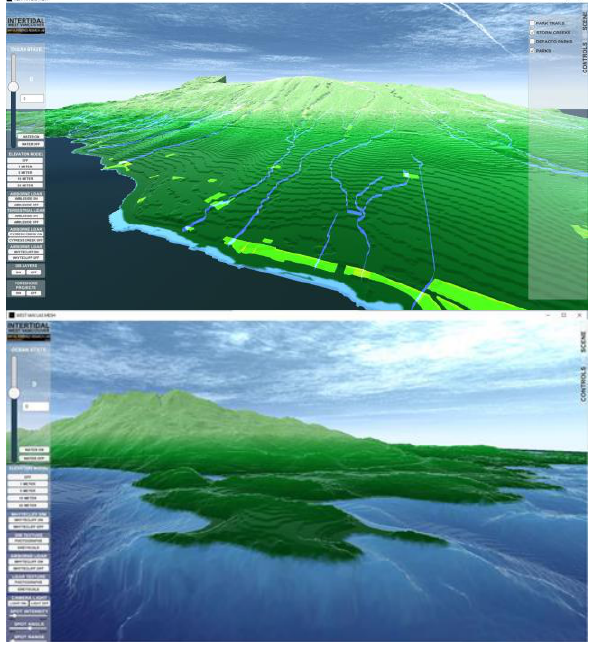
Figure 2: view of our comparative data fusion tool – supporting comparison and inspection of all available topographic data sets in order to evaluate representational veracity and resolvable